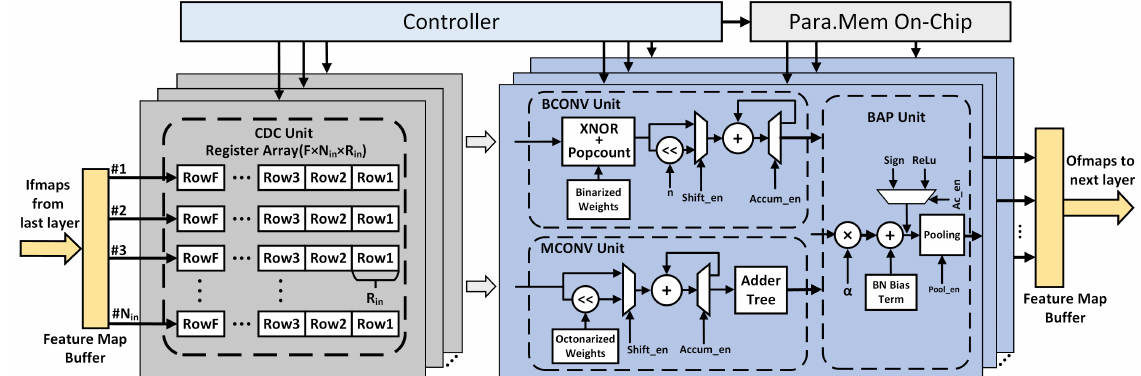
Figure 6. The block diagram of computing arrays, which consist of CDC unit, CONV unit, and BAP unit. The CDC unit is applied to cache input feature maps from last layer and generate convolution calculation data, CONV unit is responsible for convolution operation, the operations of batch normalization, activation, and pooling are performed in BAP